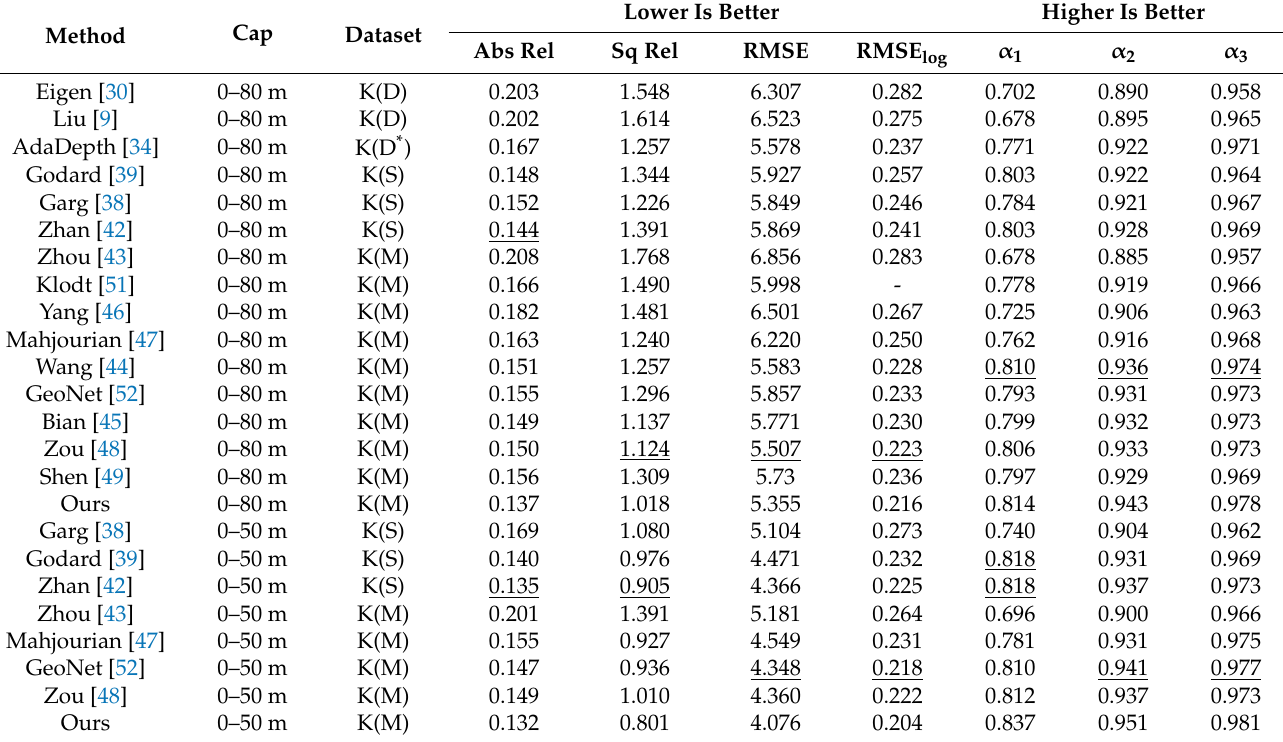
Table 2. Comparison of the proposed method with other monocular methods on the KITTI dataset, where “K” denotes our network trained on the KITTI dataset, “D” denotes methods trained with depth supervision, “D*” denotes methods trained with auxiliary depth supervision, “S” denotes methods trained using stereo pairs, and M denotes methods trained on monocular video clips, and “Cap” represents the range of valid depths. The best results in each category are in bold, and the second-best results are underlined. α i = δ < 1.25 i .